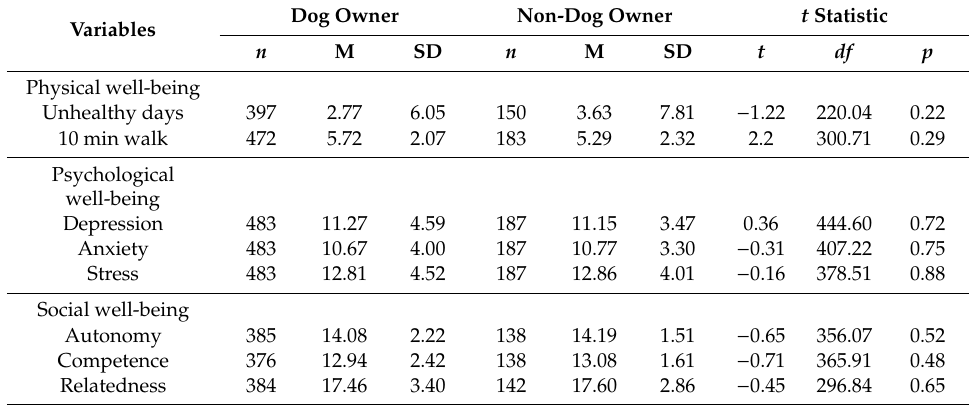
Table 8. Comparison of physical, psychological and social well-being between dog owners and non-dog